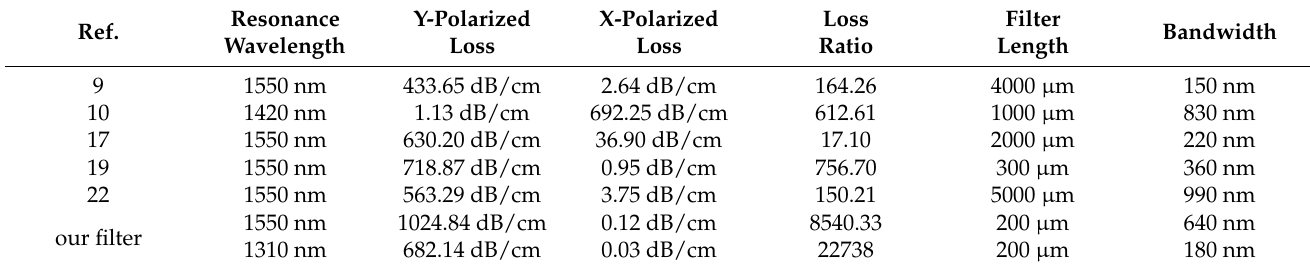
Table 3. Comparison results between the proposed filter and the previously reported filter.